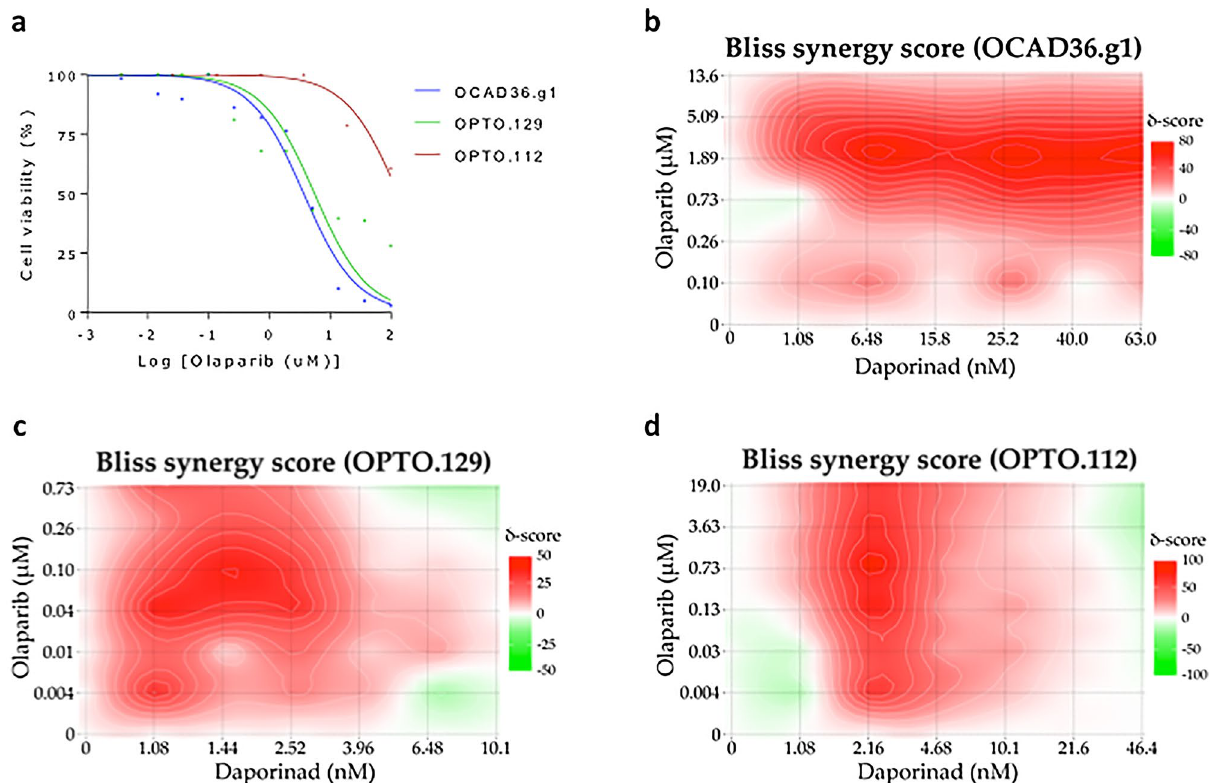
Figure 5. Primary patient organoid models. Olaparib sensitivity curves of the three organoid models ( a ). Bliss synergy maps of the combination for OCAD36.g1 ( b ), OPTO.129 ( c ) and OPTO.112 ( d ). Cell viability was measured by CellTiter-Glo 3D cell viability assay.